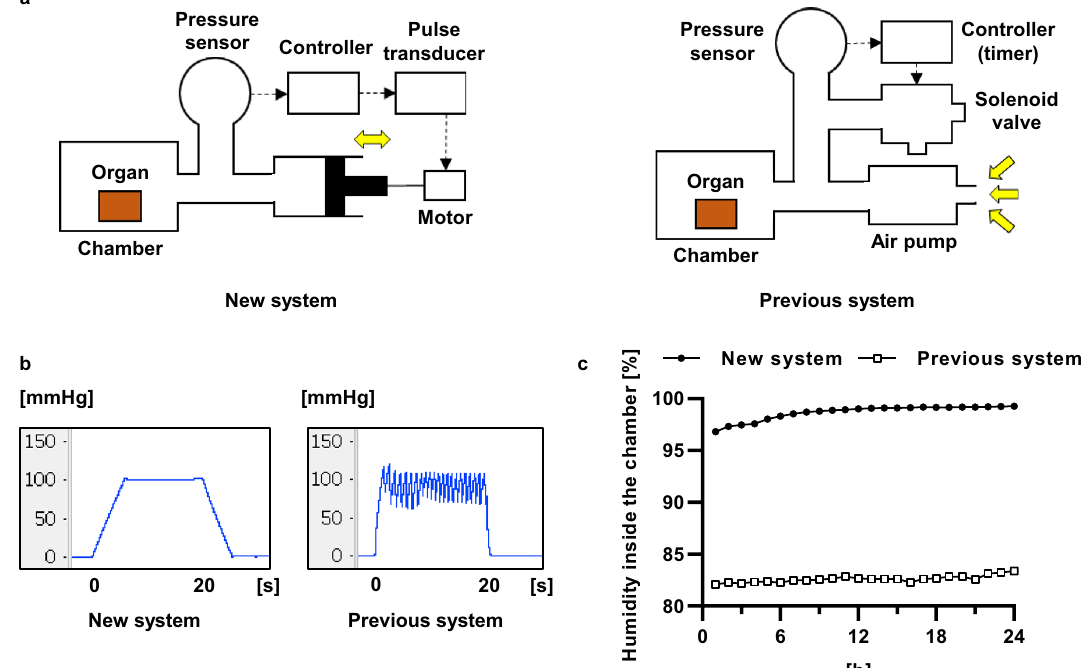
Figure 1. System for intermittent pressurization. ( a ) Schematic representation of the mechanism for intermittent pressurization. The new system operates by moving air inside an enclosed space. The previous system operated by pumping air from the outside. A sensor provides constant pressure feedback inside the chamber, pressurizing and depressurizing according to the set time. ( b ) Changes in chamber pressure at + 100 mmHg for 20 s of pressurization and depressurization using new and previous devices. ( c ) Changes in humidity inside the chamber for 24 h using new and previous devices. A sensor set inside the chamber maintained 37 °C. The data are shown as means (n =